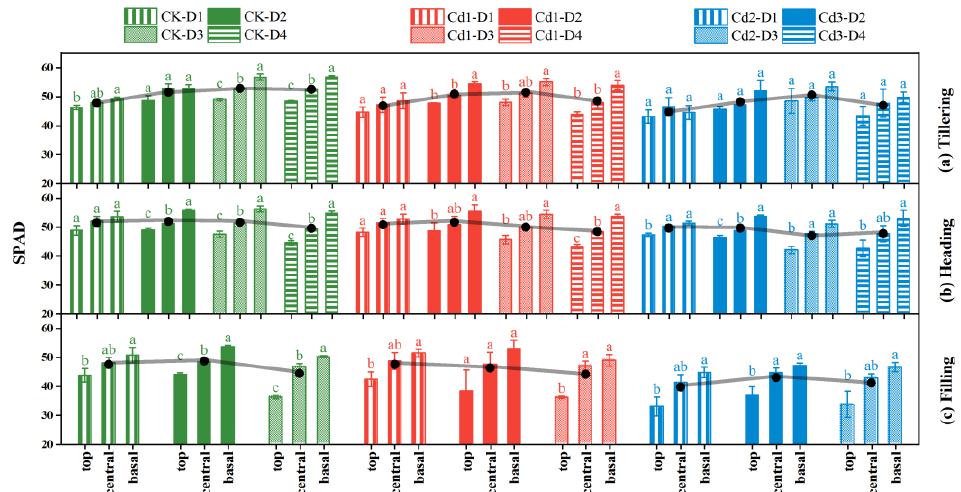
Figure 4. Rice canopy leaves of the relative chlorophyll content during different growth stages (( a ) Tillering; ( b ) Heading; ( c ) Filling). The black dot represents the average value of SPAD at the top, central and basal. D1–D4 represent the leaf position from top to bottom of the plant, lowercase letters indicate significant differences.